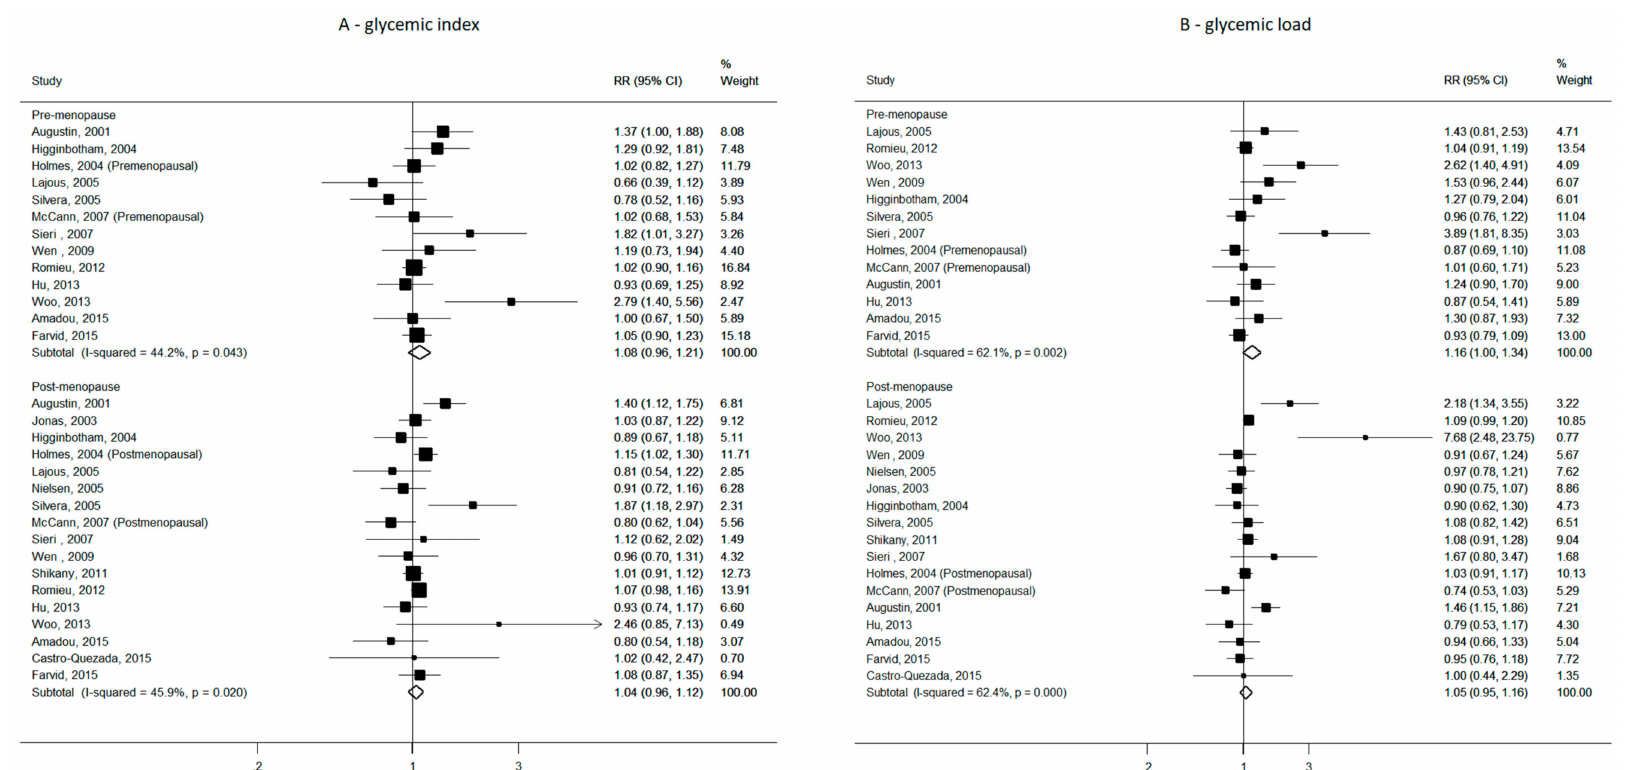
Figure 4. Study-specific and summary relative risks (RRs) of breast cancer for the highest versus the lowest category of glycemic index ( A ) and glycemic load ( B ) in strata of menopausal